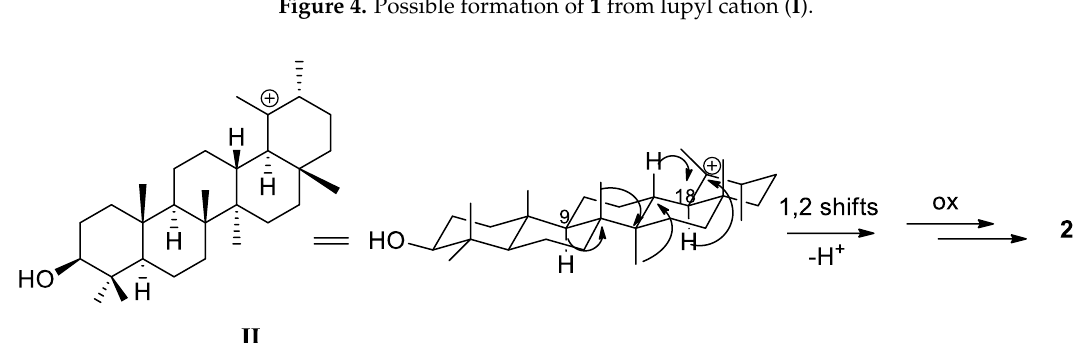
Figure 4. Possible formation of 1 from lupyl cation ( I ).